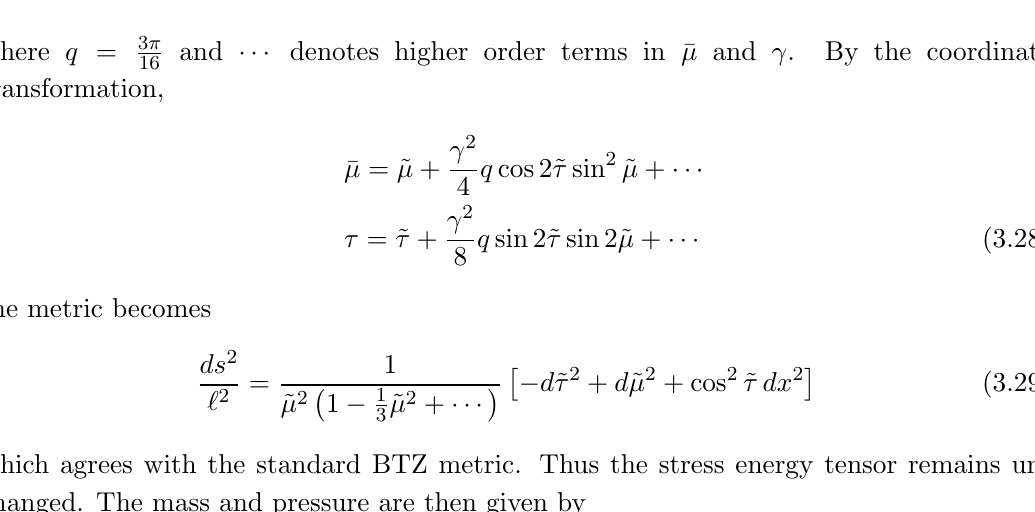
Figure 2 . The future and past horizons are depicted by straight lines. The horizon length along the future horizon grows monotonically in time. The red lines are the horizons of the right side observer whereas the blue lines represent the horizons of the left side